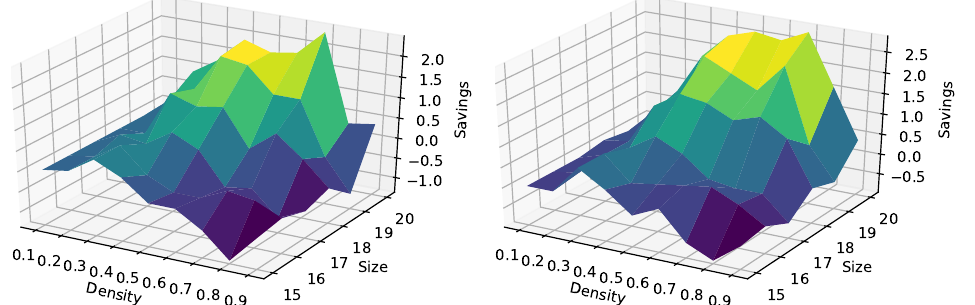
Figure 3: Average XOR count difference of the best ALOY circuits found by BP and A2